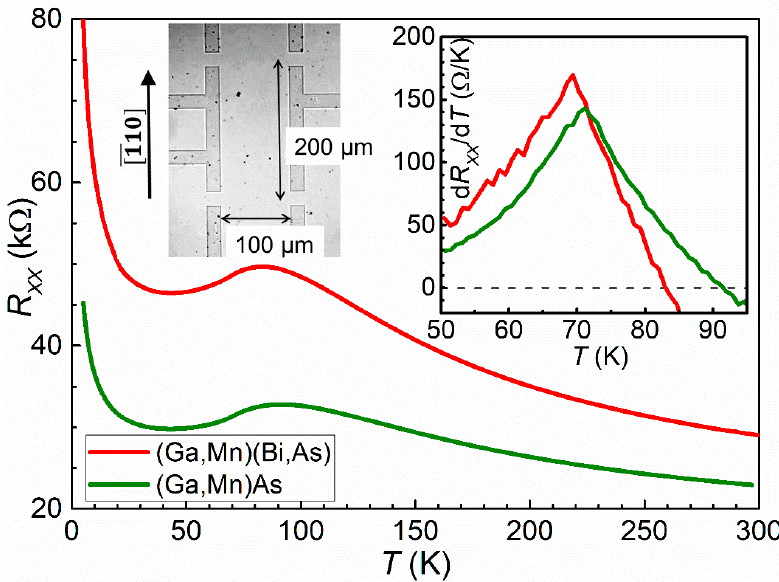
Figure 1. Temperature dependences of longitudinal resistance for the Hall bars of (Ga,Mn)(Bi,As) and (Ga,Mn)As layers. Right inset presents temperature derivatives of the resistance, in the temperature range around their maxima, where their intersections with zero value correspond to the maxima in the main figure. Microscopic image of the Hall bar and its geometry is shown in the left inset. Here, the darker contrast corresponds to non-conducting areas etched to the substrate.